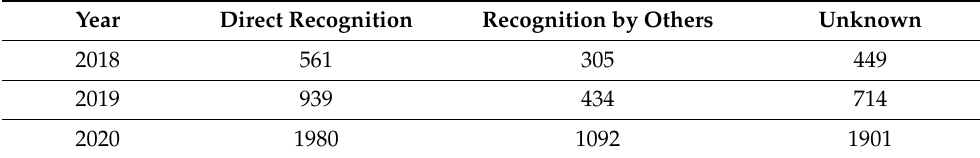
Table 4. Cognitive Path of Damage by Year [18].